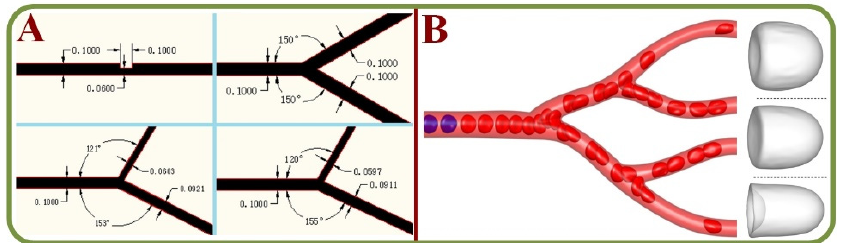
Figure 8. RBC flow analysis in bifurcating channels. ( A ) The analysis of pressure drop and flow behavior in hypertensive micro vessels with flow divisions in daughter branches of different bifurcated channels [127]. ( B ) Motion, deformation, and aggregation of multiple RBCs in three-dimensional micro vessel bifurcations with the diverging-converging bifurcations [128].